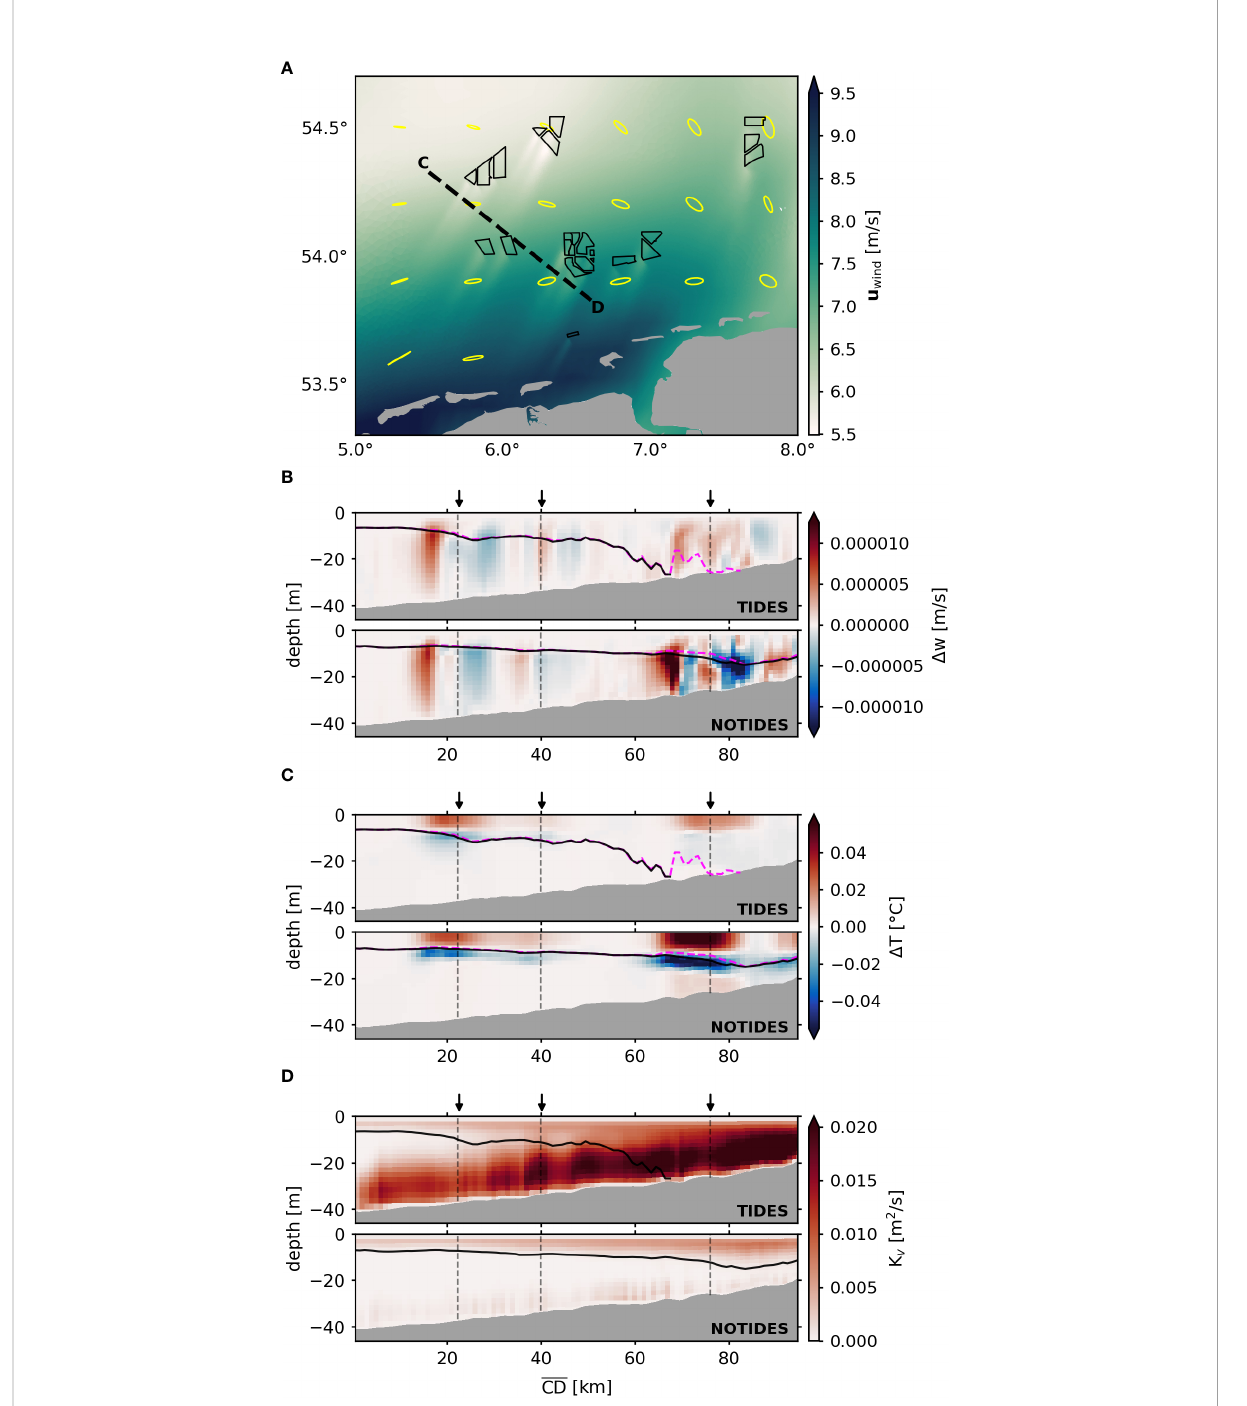
FIGURE 4 Mean wake effects along pro fi le CD for TIDES and NOTIDES on May 2 between 06:00 and 18:00. (A) Mean wind speed u over the 12-hour period, illustrating the stable wake patterns in the example region. M2 tidal ellipses are indicated in yellow. Black polygons indicate the offshore wind farms. (B) Vertical pro fi les of the mean vertical velocity changes D w over the 12-hour period in TIDES (top) and NOTIDES (bottom). Solid black line and dashed purple line show the mixed layer depth in the reference run ( REF ) and the wind farm run ( OWF ), respectively. Here, the mixed layer depth is de fi ned by the density threshold criterion of Dr = 0.03 kg/m 3 (de Boyer Monte ́ gut et al., 2004). Arrows and black and gray dashed lines indicate mean location of wind wake maxima. (C) Vertical pro fi les of the mean temperature changes D T over the 12-hour period in TIDES (top) and NOTIDES (bottom). (D) Vertical pro fi les of the vertical eddy diffusivity K v in the reference simulation (REF), indicating the mean vertical surface and bottom mixing rates in TIDES (top) and NOTIDES (bottom) over the 12-hour